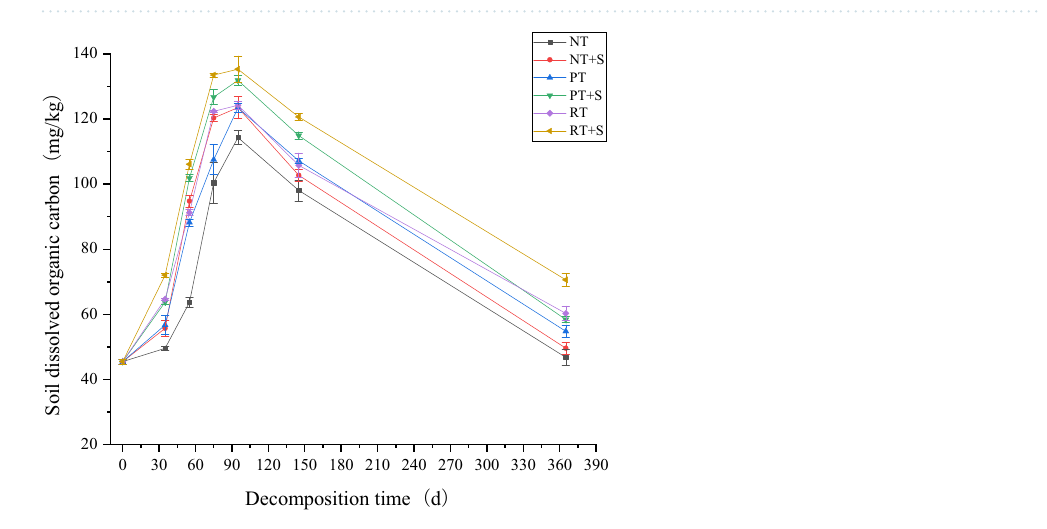
Figure 5. Changes of soil organic carbon and microbial biomass carbon under different returning modes.